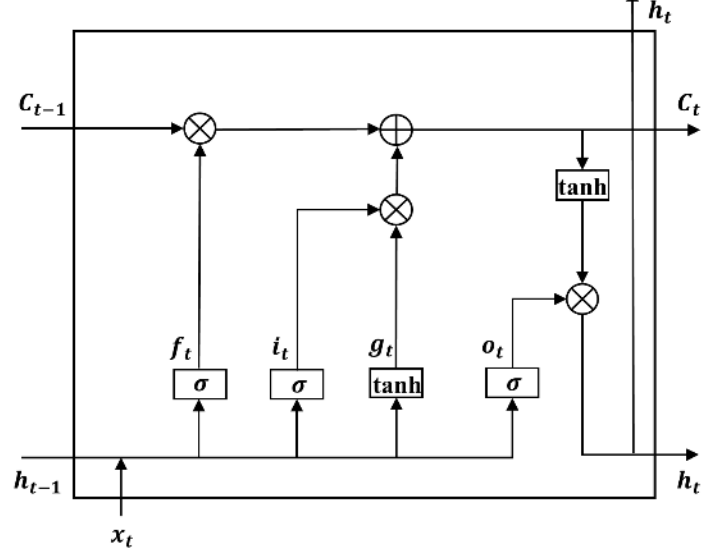
Figure 3. Network architecture of LSTM.